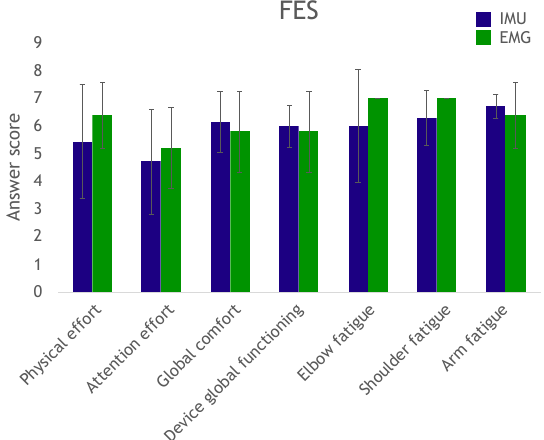
Figure 8. Questionnaire results for the robotic hand control task. The higher the value, the more positive the subject’s perception. The maximum score is always 7.